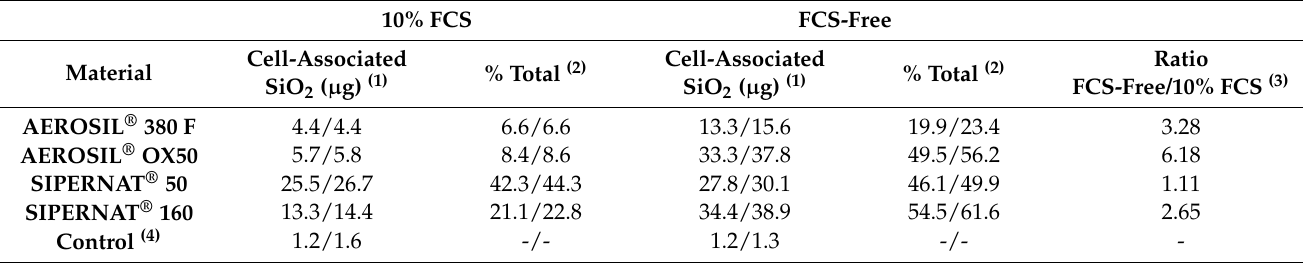
Figure 1. Sedimentation and uptake of precipitates by NR8383 cells which were formed in the presence of AEROSIL ® 380 F ( a – d ), AEROSIL ® OX50 ( e – h ), SIPERNAT ® 50 ( i – l ) and SIPERNAT ® 160 ( m – p ). Micrographs were taken 16 h after administration of particles (180 µ g/mL) in the absence (w/o cells) and presence of cells (+NR8383). Foetal calf serum (FCS) led to the formation of agglomerates. In the absence of serum, many cells appeared deteriorated. Table 2. Quantification of SiO 2 uptake in the absence and presence of foetal calf serum